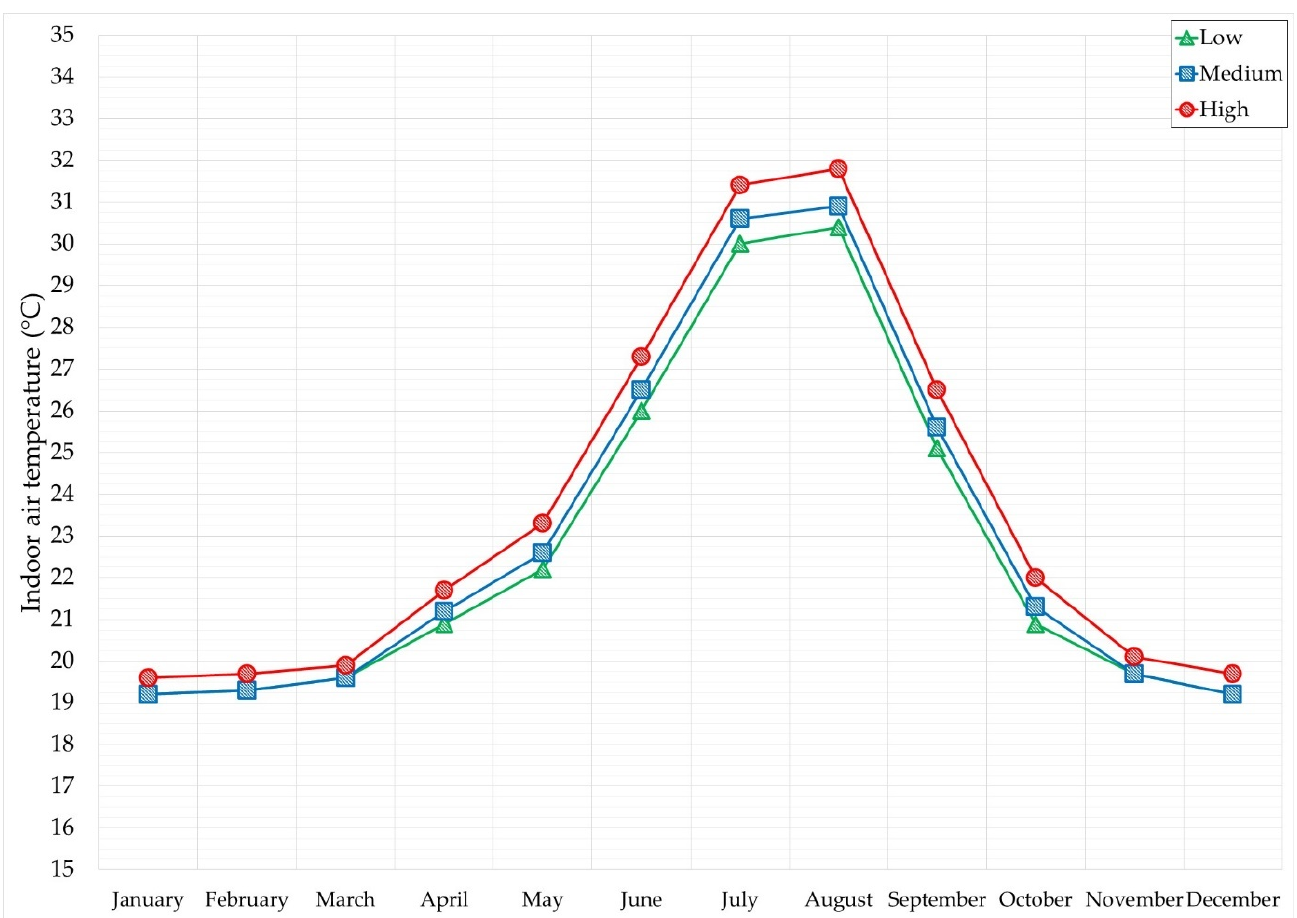
Figure 9. Indoor air temperature reached within the environment by adopting the three defined profiles.